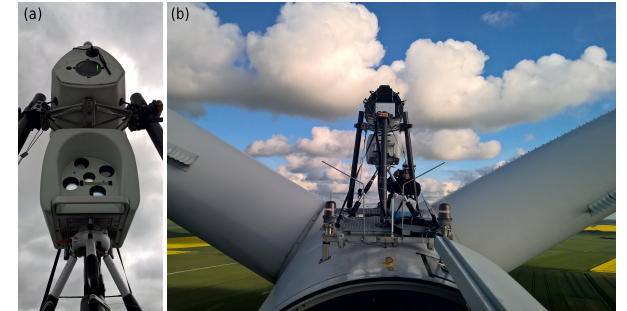
Figure 4. Measurement campaign in Nørrekær Enge (Denmark): the five-beam Avent Demonstrator and ZephIR Dual Mode lidars mounted on a Siemens 2.3MW turbine. The five-beam Demonstra- tor is below the ZephIR Dual Mode. (a) From the front; (b) from the